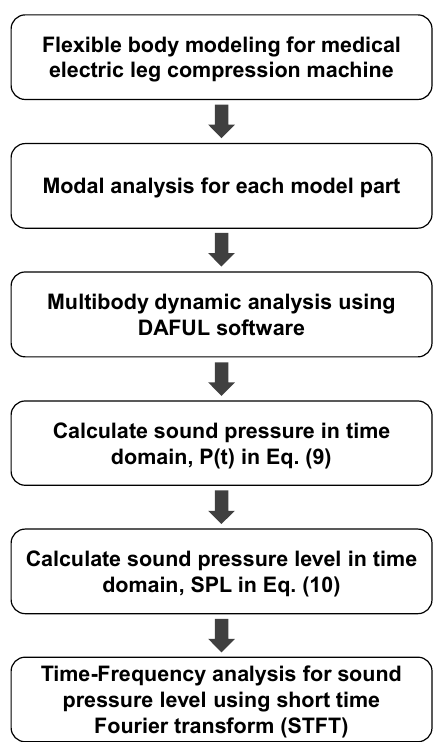
Figure 3. Calculation flow chart.